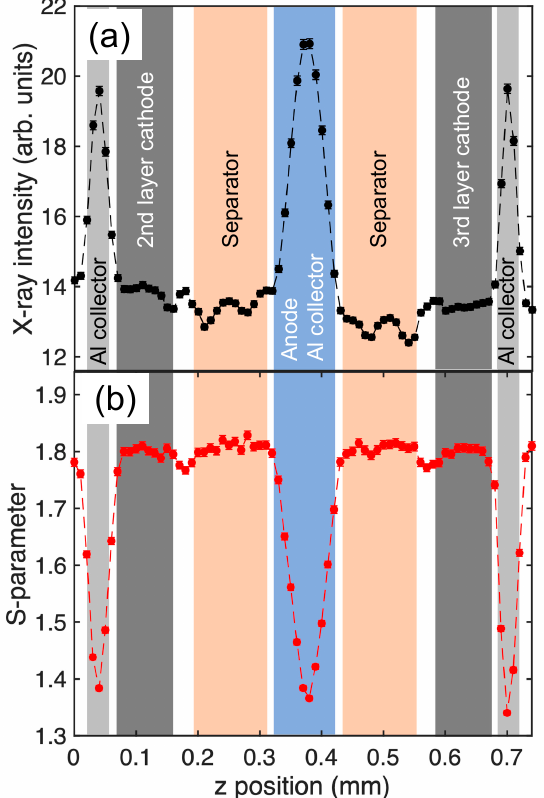
Figure 4. Schematic view of ( a ) Compton scattered X-ray spectrum; ( b ) S − parameter obtained non − destructively from inside the structure of the capacitor cell. Background shades correspond to the regions of the component of the capacitor cell.